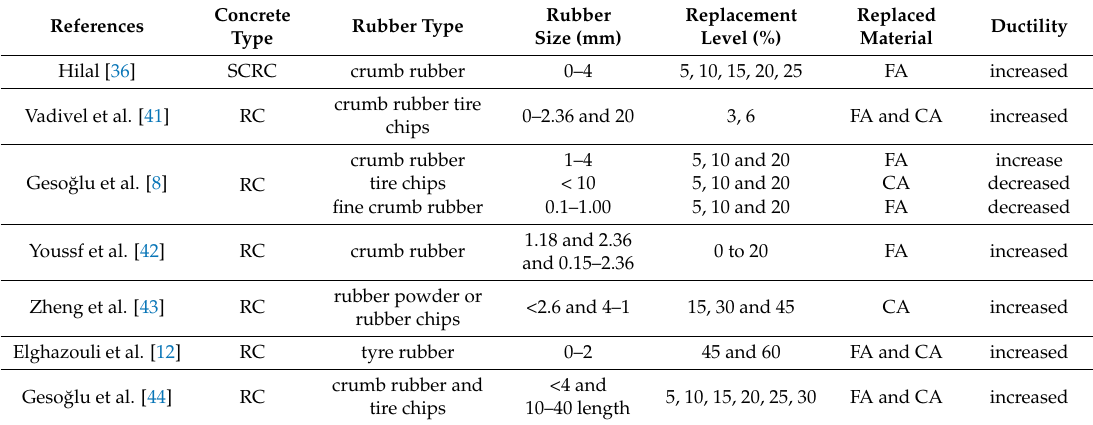
Table 7. Influence of rubber inclusion on ductility of self-compacting rubberized concrete (SCRC) and rubberized concrete